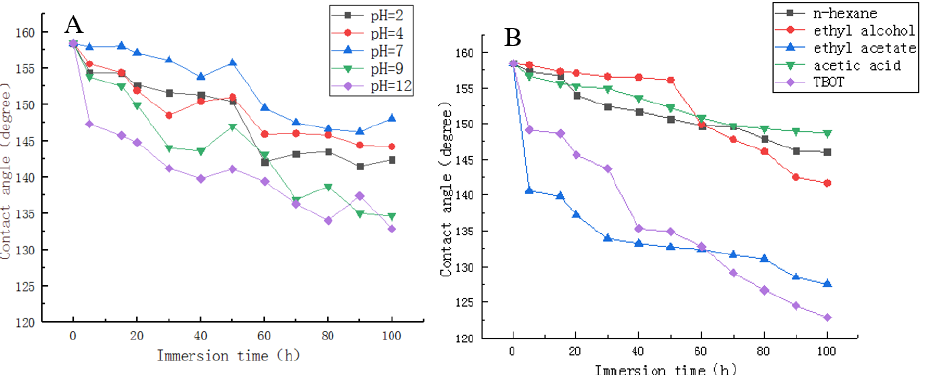
Figure 4. Di ff erent pH values of solution and organic solvent immersion test of ZnSt2 / WUV ( A : Figure 4. Different pH values of solution and organic solvent immersion test of ZnSt2/WUV ( A : immersion in di ff erent pH solutions; B : immersion in di ff erent organic immersion in different pH solutions; B : immersion in different organic solvent).